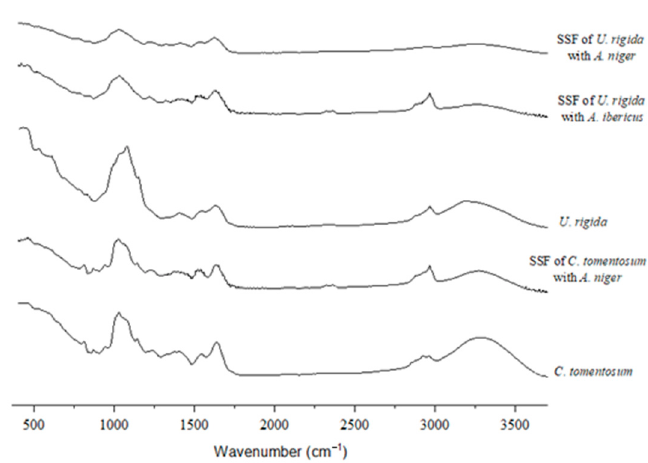
Figure 4. FTIR-ATR spectra of green seaweeds.